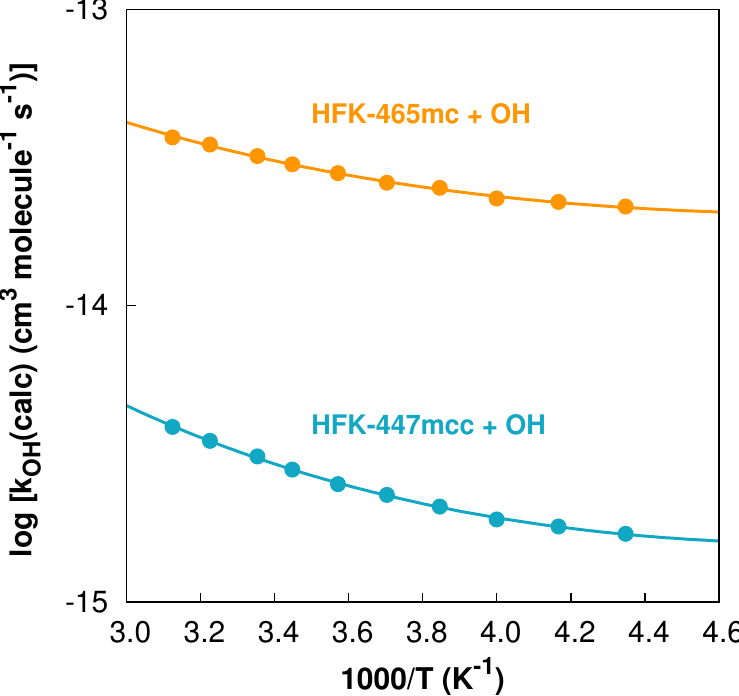
Figure 4. Arrhenius–Kooij fits (solid lines) and k OH ( calc ) data points (solid circles) for both reactions in the 230 ≤ T /K ≤ 320 temperature